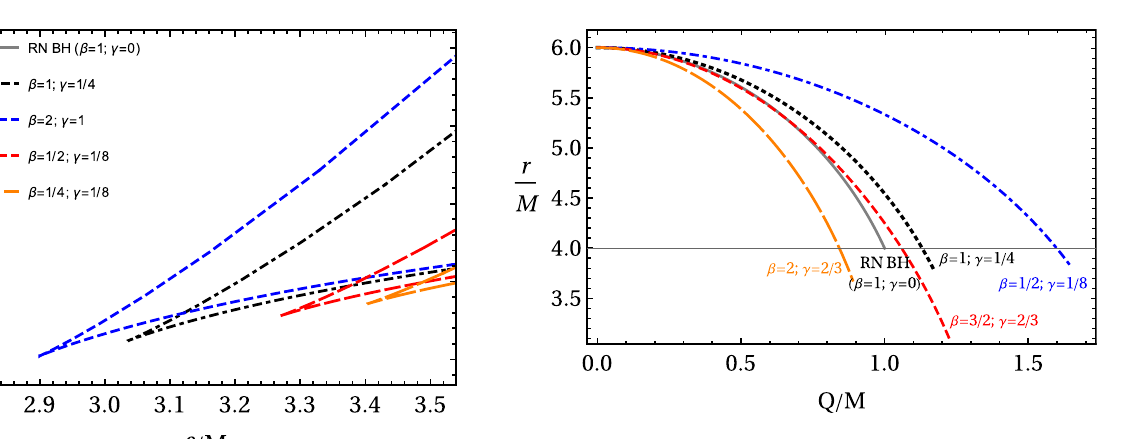
Fig. 6 Dependence of ISCO radius from the BH charge for different values of EMS parameters β and